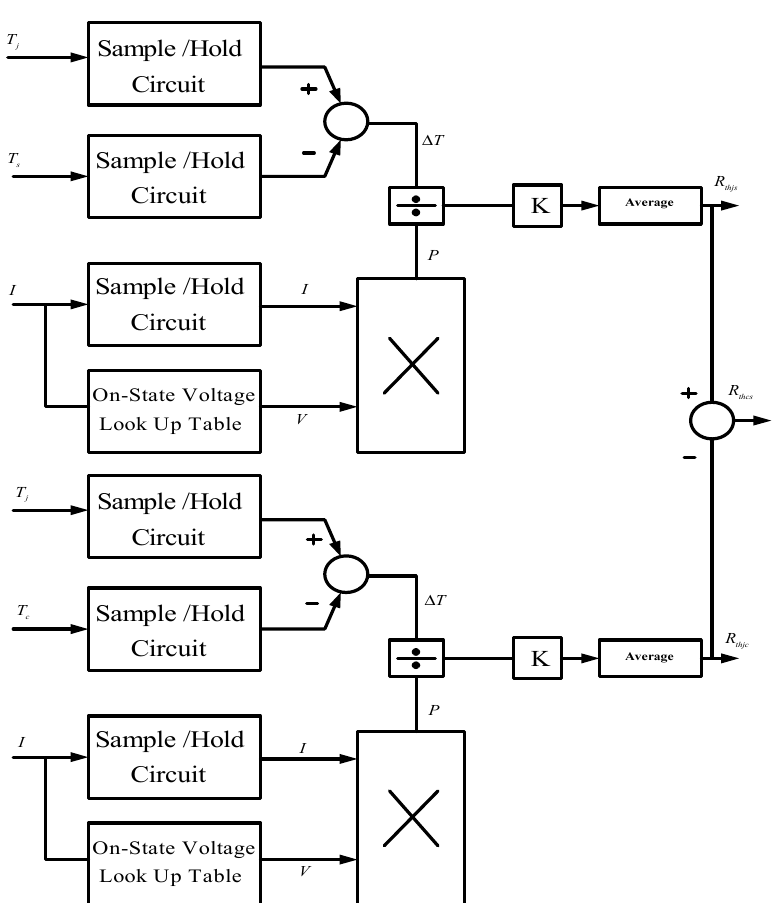
Figure 22. Integrated power module monitoring unit [55].